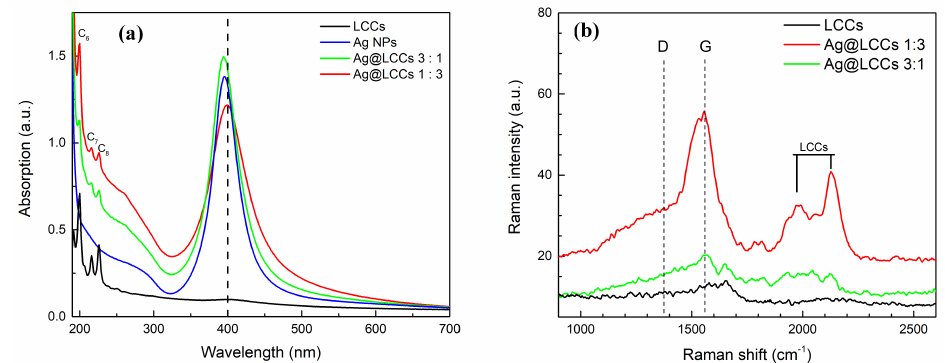
Figure 4. ( a ) UV–Vis optical absorption and ( b ) Raman spectra of all the samples. LCCs (black line), Ag NPs (blue line), and Ag@LCC formulations at the two different ratios (3:1—green line; 1:3—red line). C n labels refer to LCC electronic transitions, while D and G bands represent the